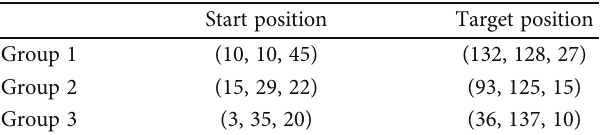
Table 4: Three sets of UAV starting points and target